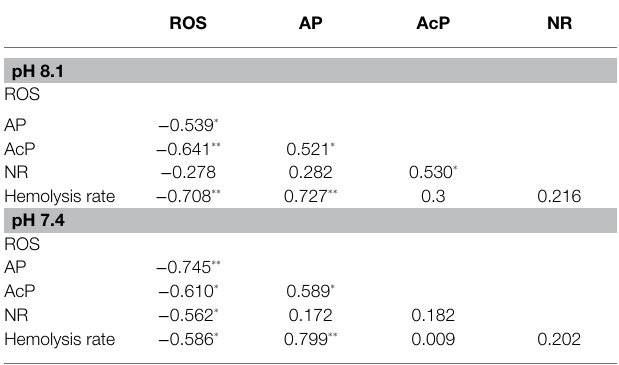
TABLE 6 | Pearson’s correlation coefficients among parameters under seawater acidification conditions when exposed to different nutrient statuses.